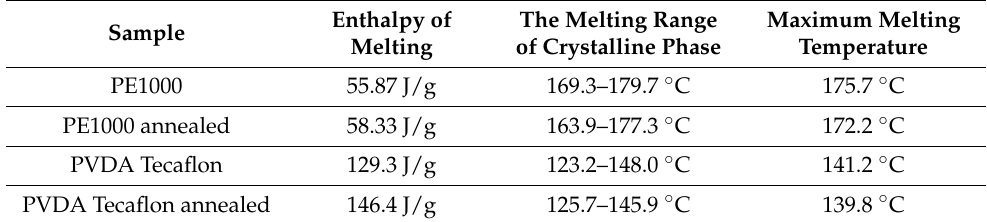
Table 2. The results of material testing using the DSC (differential scanning calorimetry)